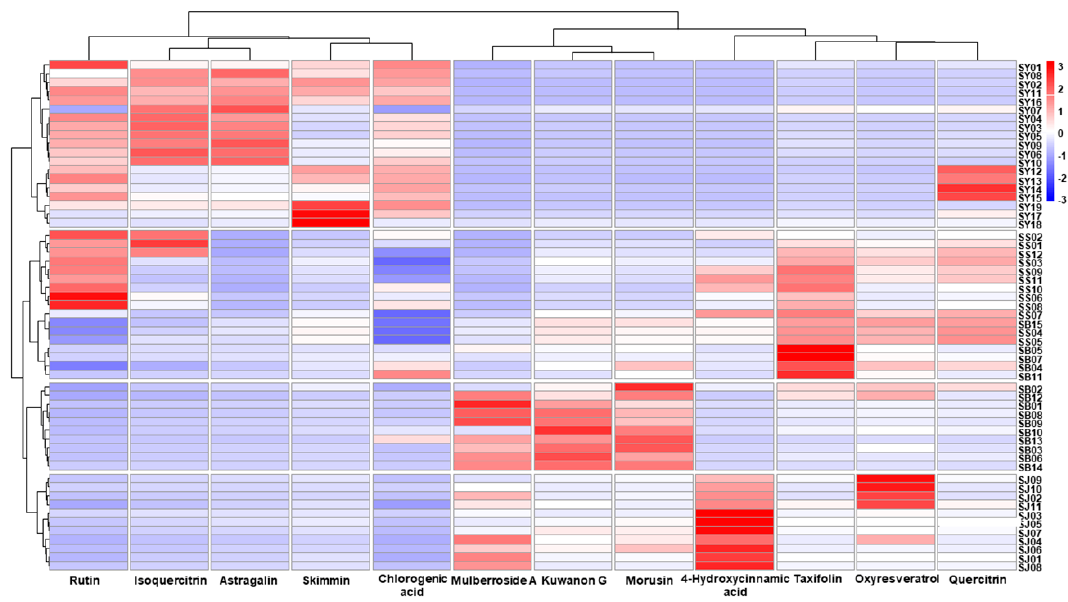
Figure 6. Clustered heatmap of the Morus samples and the marker compounds. SB, root barks; SJ, twigs; SS, fruits; SY, leaves.